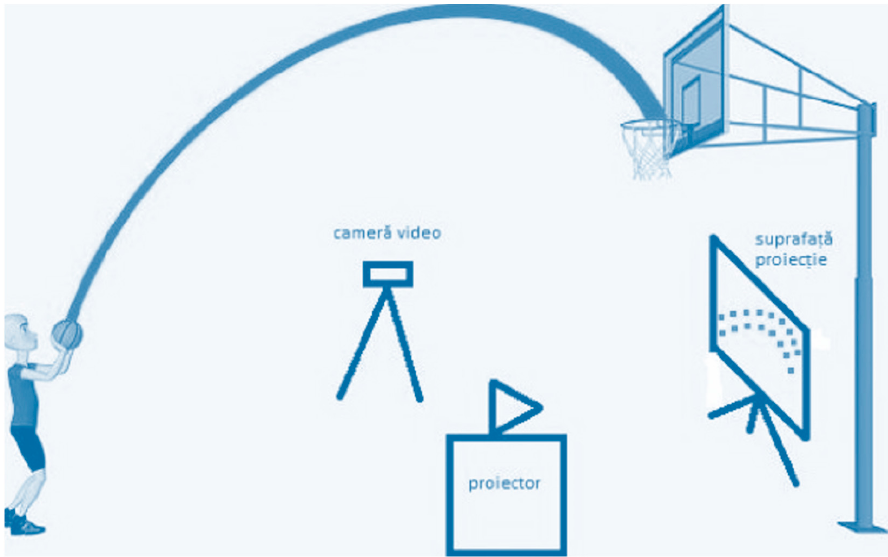
Figure 2. Superimposition of the execution trajectory on the ideal one.